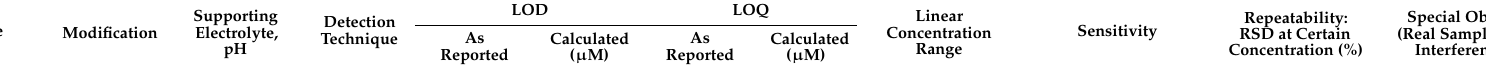
Special Observation (Real Sample Analysis, Interferences, ...